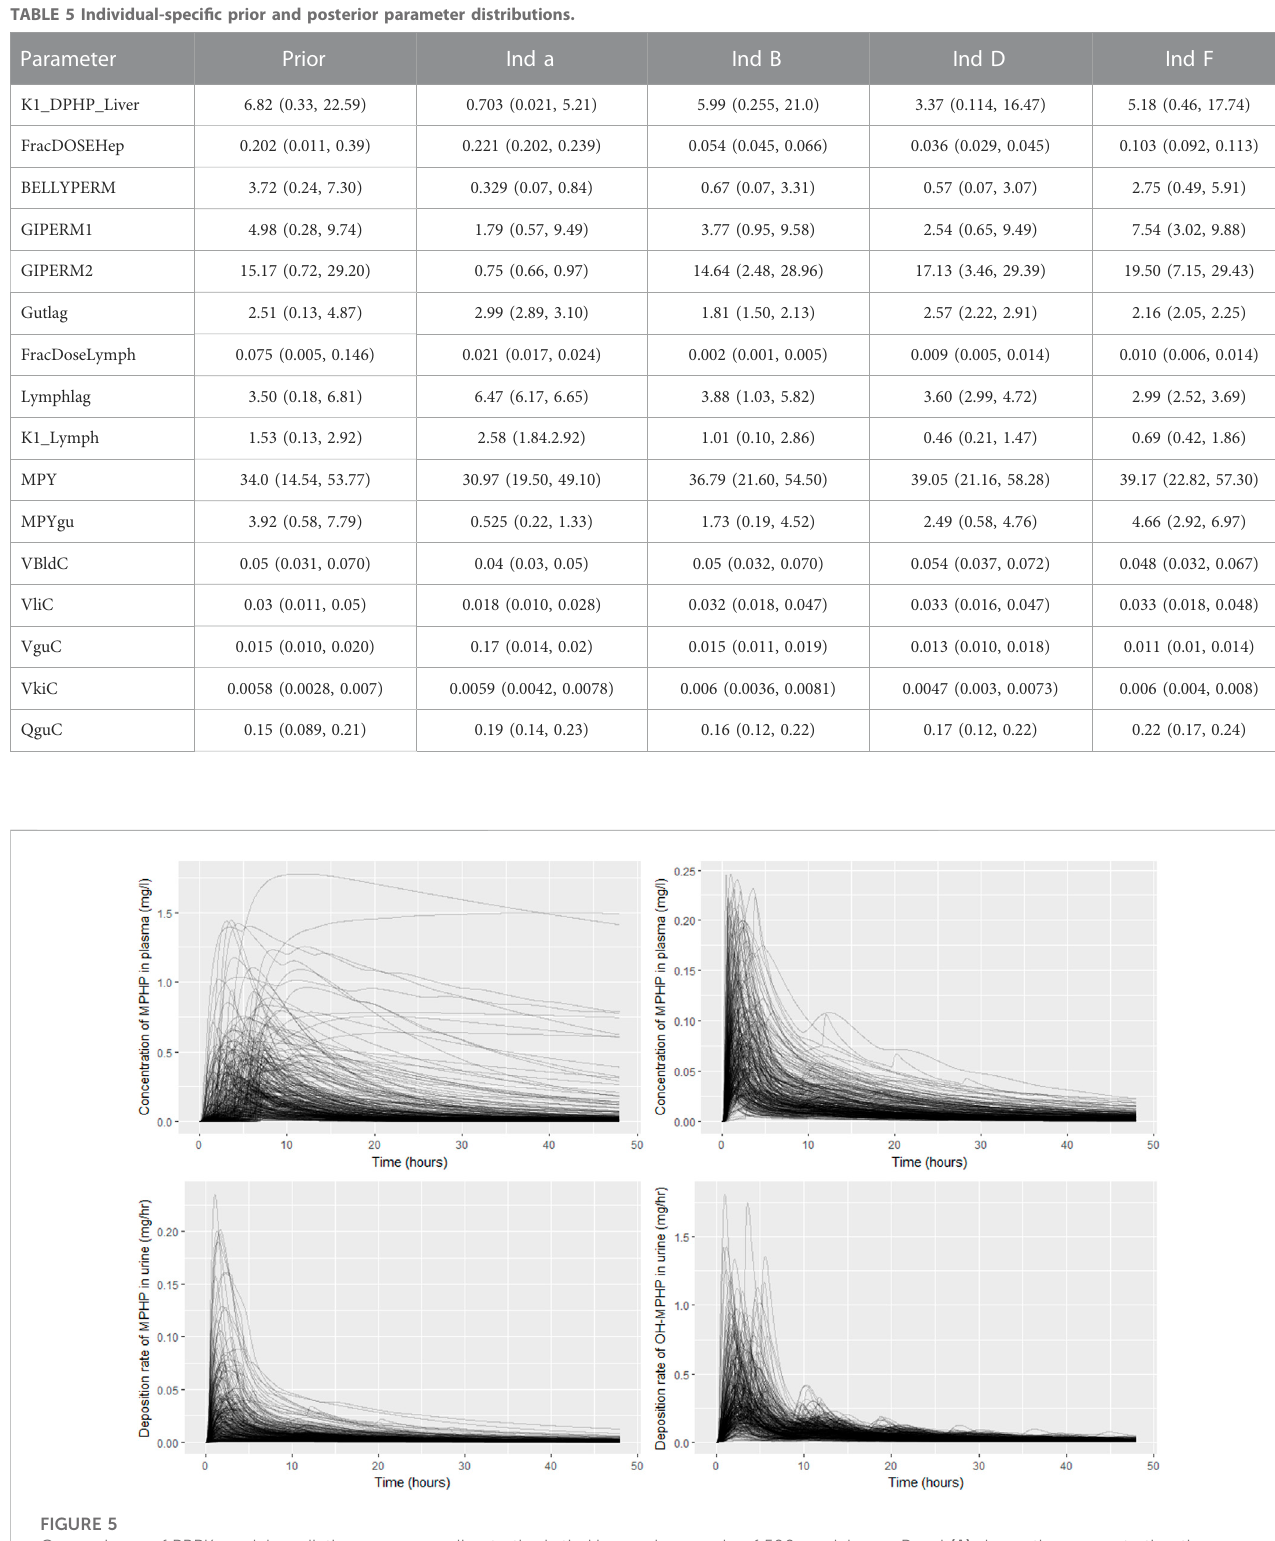
FIGURE 5 Comparisons of PBPK model predictions corresponding to the Latin Hypercube sample of 500 model runs. Panel (A) shows the concentration time pro fi lesforMPHPinvenousblood(mg/L)forthe500samples;panel (B) showstheretainedsampleof248pro fi lesforMPHPinvenousblood(mg/L)following the rejection step; panel (C) shows rate of deposition of MPHP into the urine (bladder) (mg/h) for the retained sample; panel (D) shows rate of deposition of OH-MPHP into the urine (bladder) (mg/h) for the retained